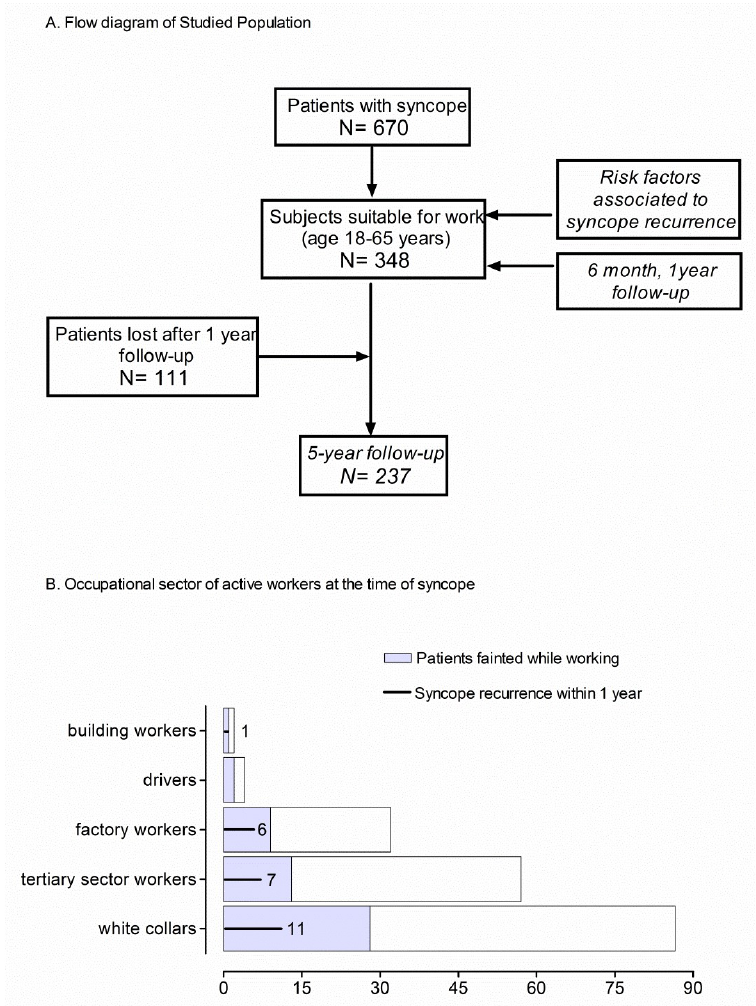
Figure 1. ( A ) The flow diagram shows the design of the study. Subjects suitable for work were enrolled as part of the STePS study (19). Recurrence risk of syncope relapse was estimated within 5-year follow-up. 111 patients were lost after the 1st year of follow-up. The risk factors associated with syncope relapse at 6-month and 1-year follow-up were evaluated in all patients. ( B ) Bars summarize the occupational sector of active workers at the time of first syncope. Each bar indicates the number of workers employed in specific occupational sector. Gray shaded areas indicate the number of subjects who fainted while working and black lines indicate the number of syncope recurrences within 1 year from the first syncope event in each different group of active